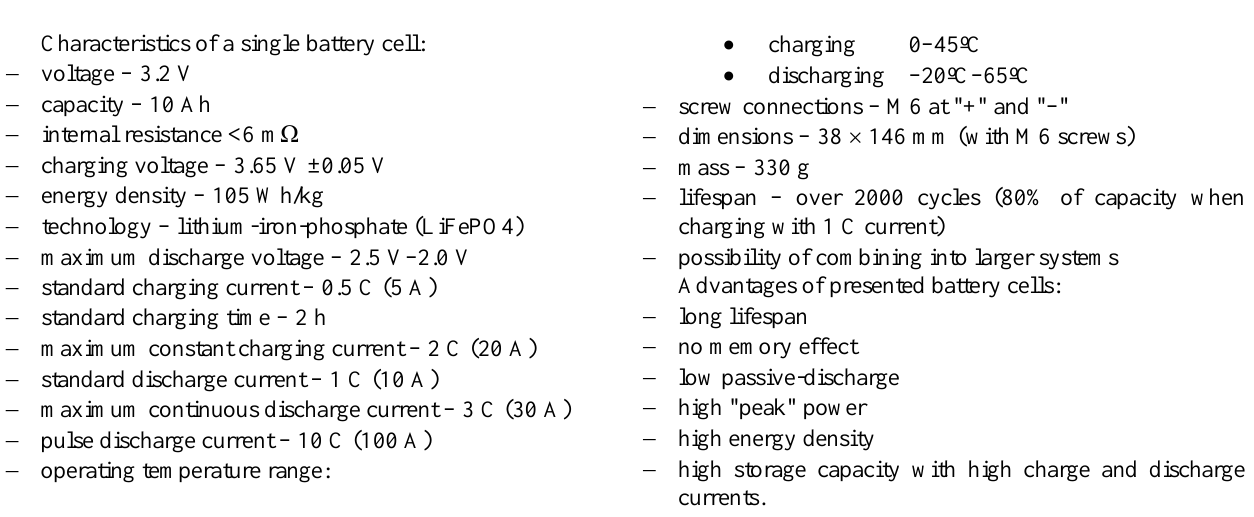
Fig. 6. A single battery cell and its discharge characteristics